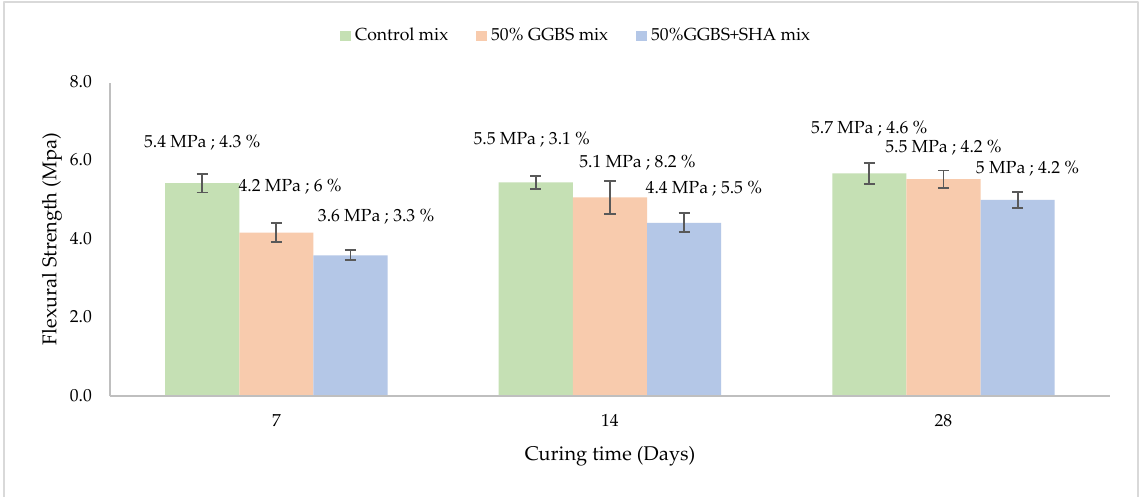
Figure 8. Mix comparison (Flexural Strength; Coefficient of variation).